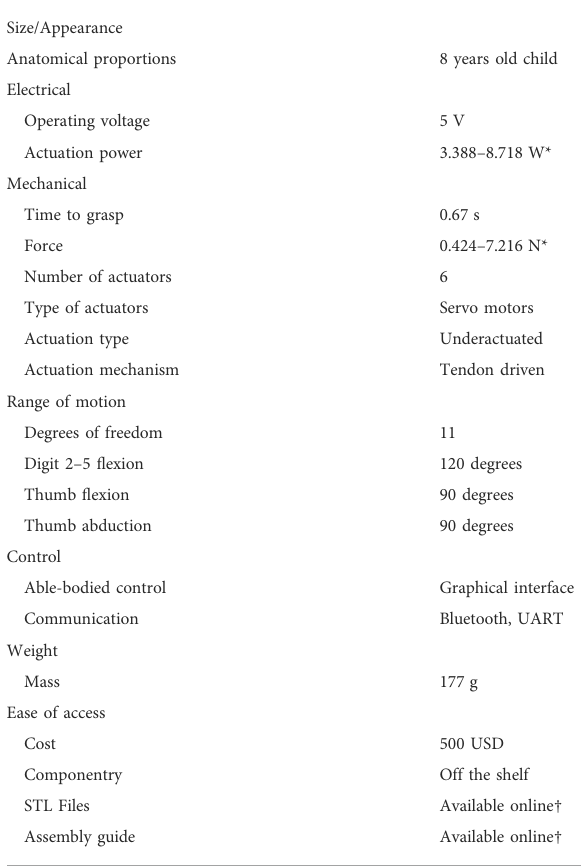
TABLE 4 BEAR PAW achieved speci fi cations. *Values obtained as explained in the Materials and Methods subsection on Mechanical and Electrical Performance and the detailed analysis are provided in the corresponding Results section. † The STL fi les and assembly guide can be found at https://github.com/BEAR-Labs/BEAR-PAW.